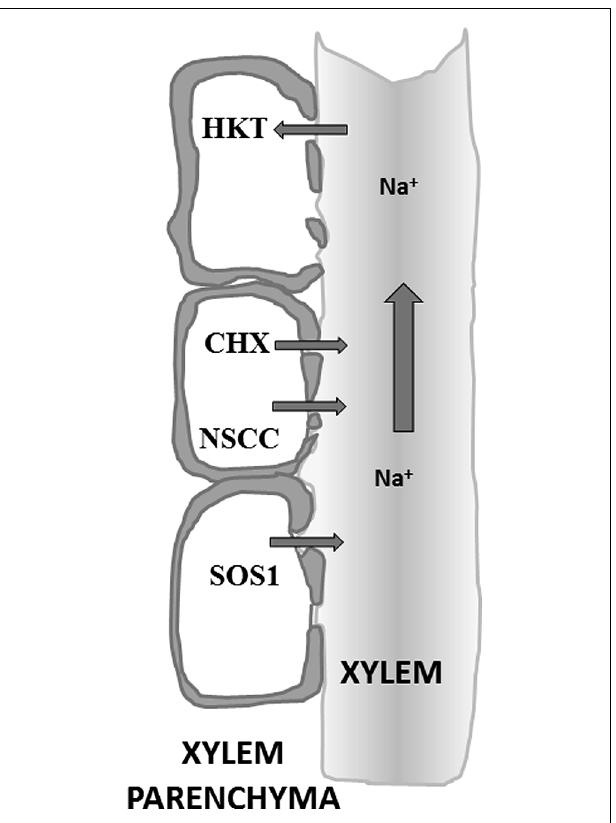
FIGURE 3 | Schematic of the xylem and xylem parenchyma anatomy. The xylem parenchyma consists of life cells that unload Na + across their plasma membrane into the apoplast and xylem lumen (non-living tissue). Once in the xylem, bulk flow under positive and negative pressure ensures transport of minerals to shoot